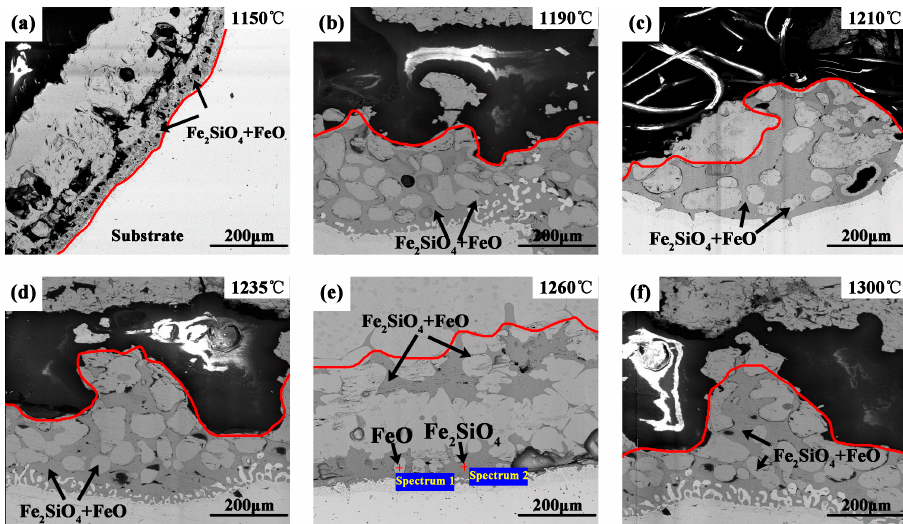
Figure 2. SEM cross-section micrographs showing the distribution of Fe 2 SiO 4 at different oxidation temperatures: ( a ) 1150 °C; ( b ) 1190 °C; ( c ) 1210 °C; ( d ) 1235 °C; ( e ) 1260 °C; ( f ) 1300 °C.